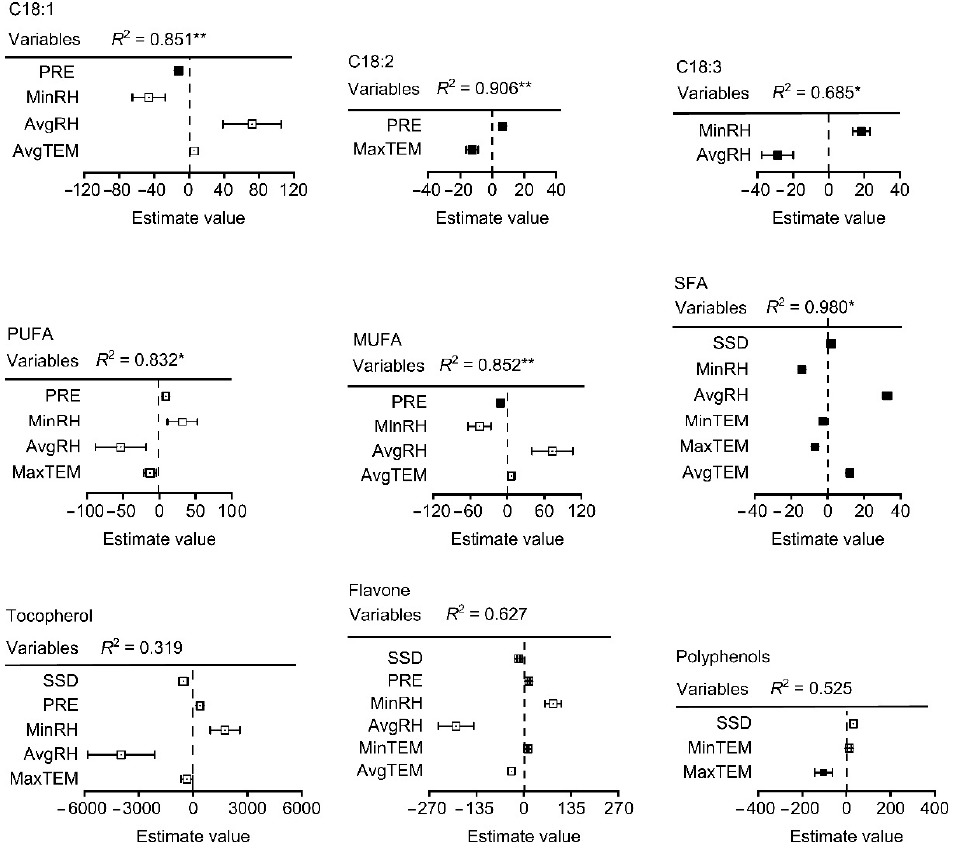
Figure 6. Results of multiple regressions after the selection process of the climatic factors affecting the fatty acid content of walnut oil. Note: Each variable was standardized before comparing effect sizes (squares) to determine differences in the strength of the predictor variables. Variables were selected based on a full set regression. Closed squares indicate significant effects ( p ˂ 0.05) and lines indicate standard errors. * and ** indicate a significant difference ( p ˂ 0.05, 0.01), respectively.